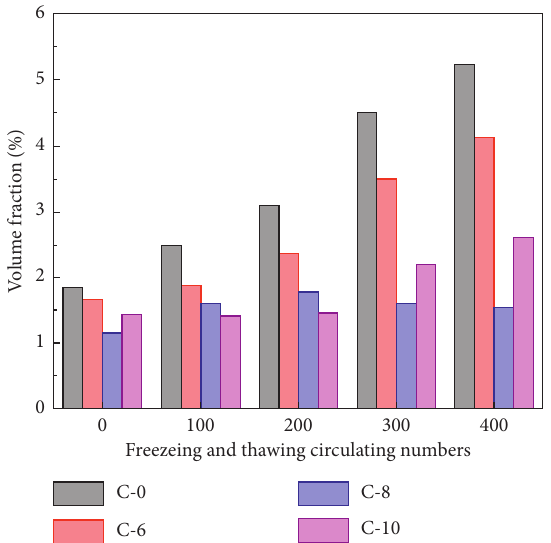
Figure 18: Porosity changes of concrete with different CaO contents and 0–400 F-T cycles.